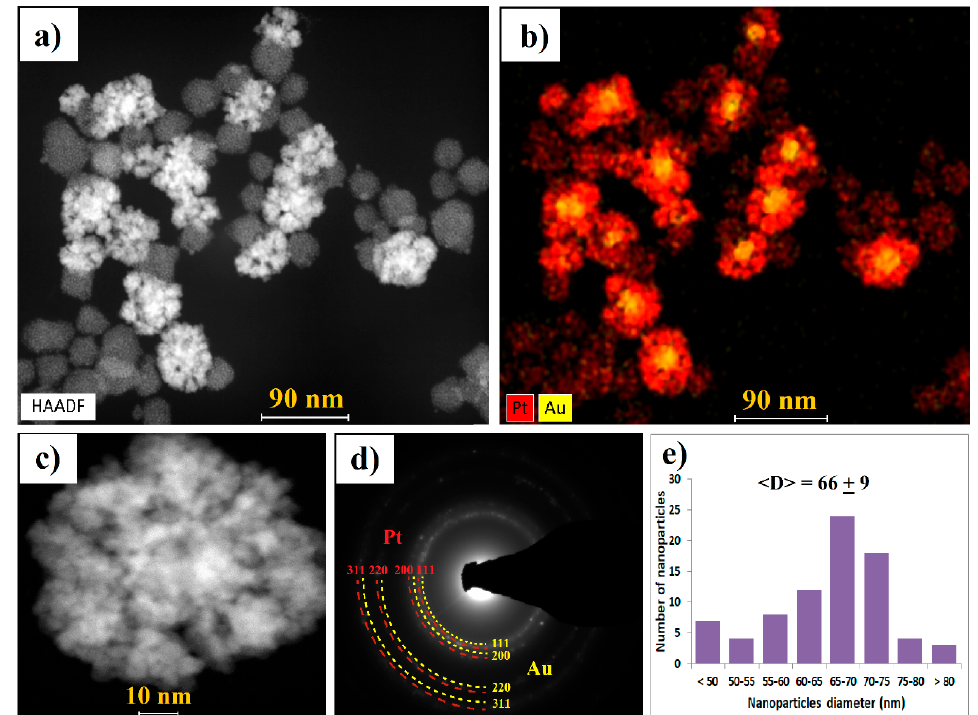
Figure 3. Morphology of AuPt NCs: ( a ) scanning transmission electron microscopy (STEM) High-angle annular dark-field detector (HAADF) overview image, ( b ) energy dispersive X-ray spectroscopy (EDS) distribution map of gold (yellow) and platinum (red) in AuPt NCs, ( c ) STEM HAADF higher magnification image, ( d ) corresponding selected area electron di ff raction (SAED) pattern, and ( e ) size distribution of AuPt NCs.